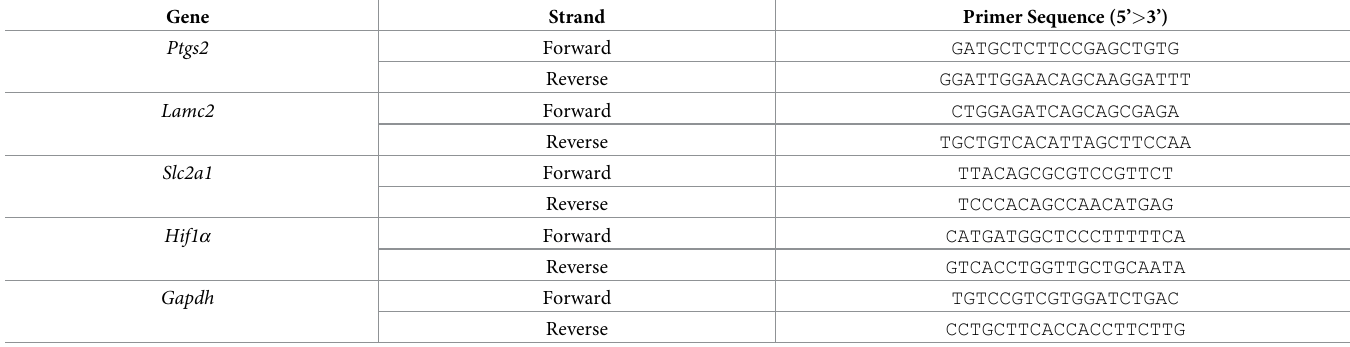
Table 1. Sequence of primers used in